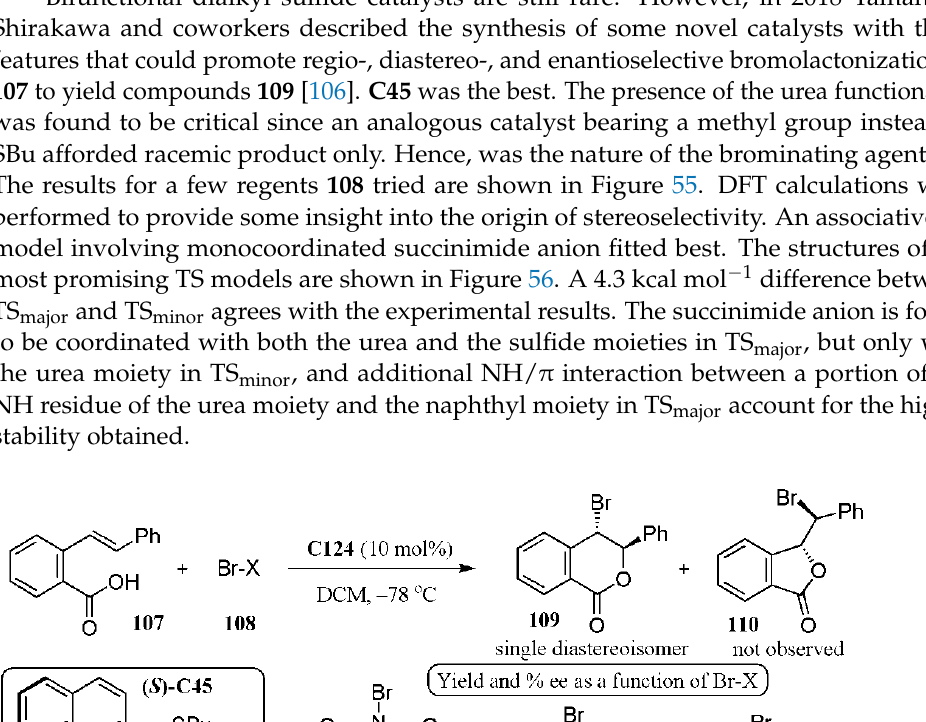
Figure 54. Enantioselective Pictet–Spengler reaction catalyzed by C44 [103,104].